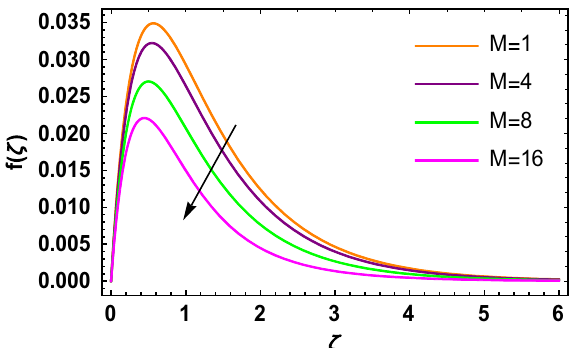
Figure 3. f (ζ) versus M .